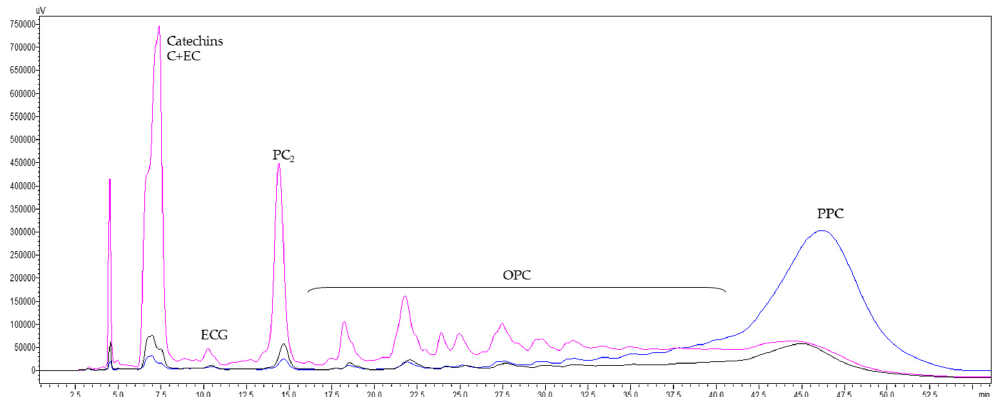
Figure 3. Overlay of NP-HPLC-PAD chromatograms of 20 mg/mL of grape seed extract (GSE) (black) and its oligomeric procyanidin (OPC) (violet) and polymeric procyanidin (PPC) (blue) fractions acquired at 280 nm. C+EC—catechin and epicatechin; ECG—epicatechin gallate; PC 2 —procyanidin dimers; OPC—oligomeric procyanidins; PPC—polymeric procyanidins.